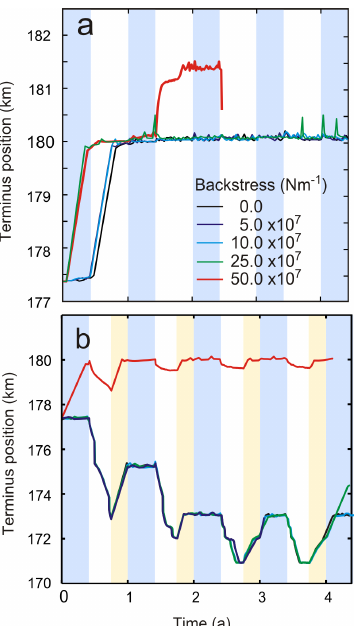
Fig. 8. Terminus evolution of modelled glacier with varying back- stress applied. (a) No water in crevasses, (b) seasonally varying cwd applied with a winter value of 0m and summer value of 30m. The two subfigures have different vertical scales. In (a) and (b) , blue shading indicates winter when backstress is applied and there is no water in crevasses. White shading indicates summer when backstress is zero and there may be water in crevasses. In (b) , yel- low shading indicates autumn when there is no backstress and the crevasses are dry. In (b) all lines overlie each other, with the ex- ception of 50.0 × 10 7 Nm − 1 , which shows different terminus be- haviour.